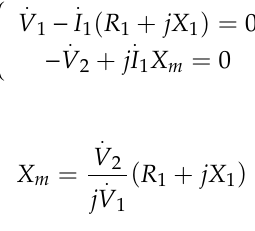
Figure 3. Equivalent circuit of two coupled magnetic coils [AC: controllable voltage source; ω : frequency of voltage source; R 1 , R 2 : equivalent resistances of coupled windings; L σ 1 , L σ 2 : inductivities of magnetic leakage paths in both coils; L σ m : mutual inductance between windings; A/V: tester for voltage and current measurements].